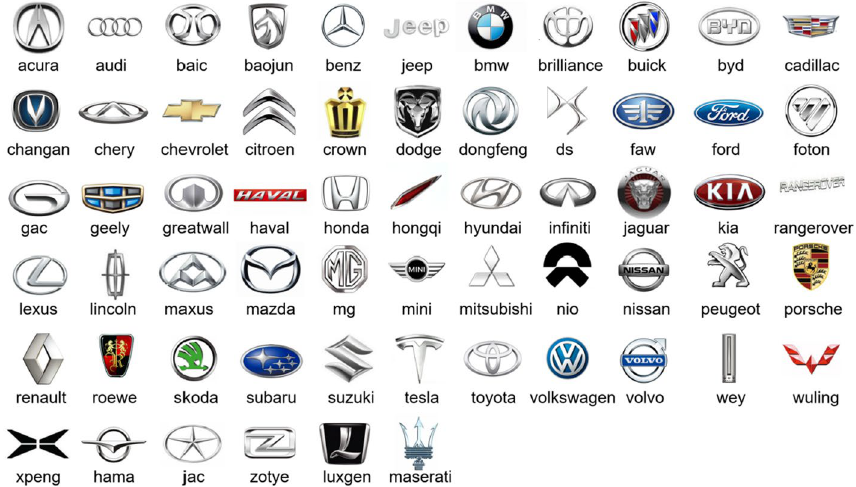
Proportion of target refers to the ratio of the area of the vehicle logo to that of the image